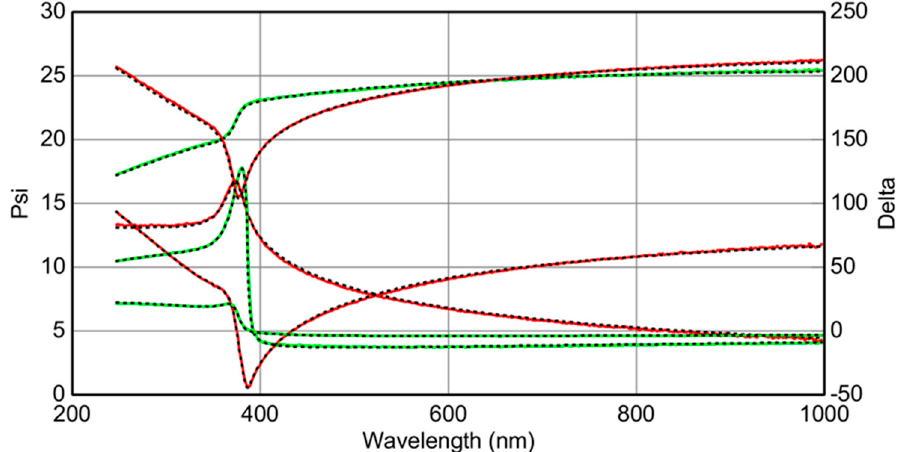
Figure 11. Fitting of measured data for ellipsometric parameters Ψ and ∆ for sample spinning speed of 3500 rpm using variable angle spectroscopic ellipsometric (VASE) data where the red line is the measured and the green line is the fitted.